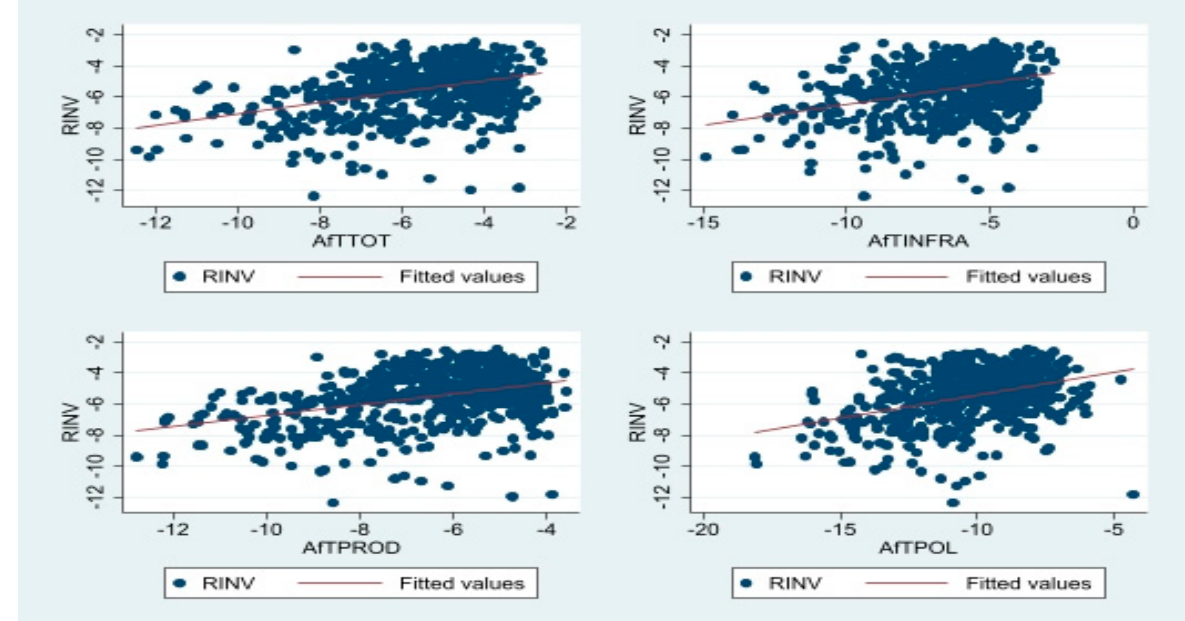
Figure 2. Total AfT flows and remittance-oriented investment flows over the subsamples of LDCs and non-LDCs. Source: Author. Note: The variables “RINV1” and “AfTTOT1” are respectively the share of remittance-oriented investment flows in GDP and the share of total AfT flows in GDP, both expressed in percentages, for the sake of the graphical analysis.